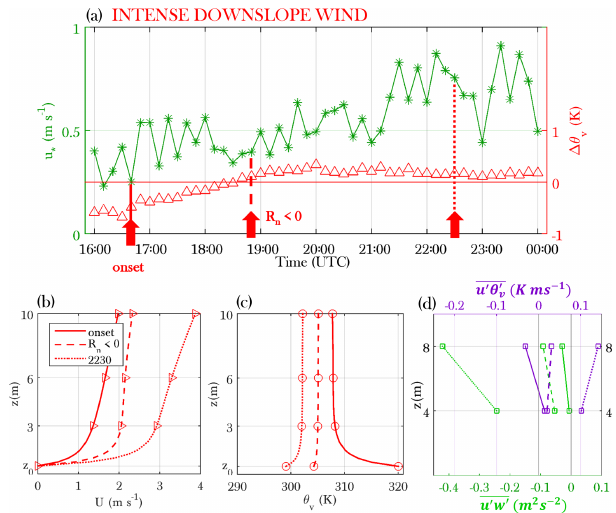
Figure 10. (a) Idem from Fig. 8 for the intense downslope event (27 July 2017).